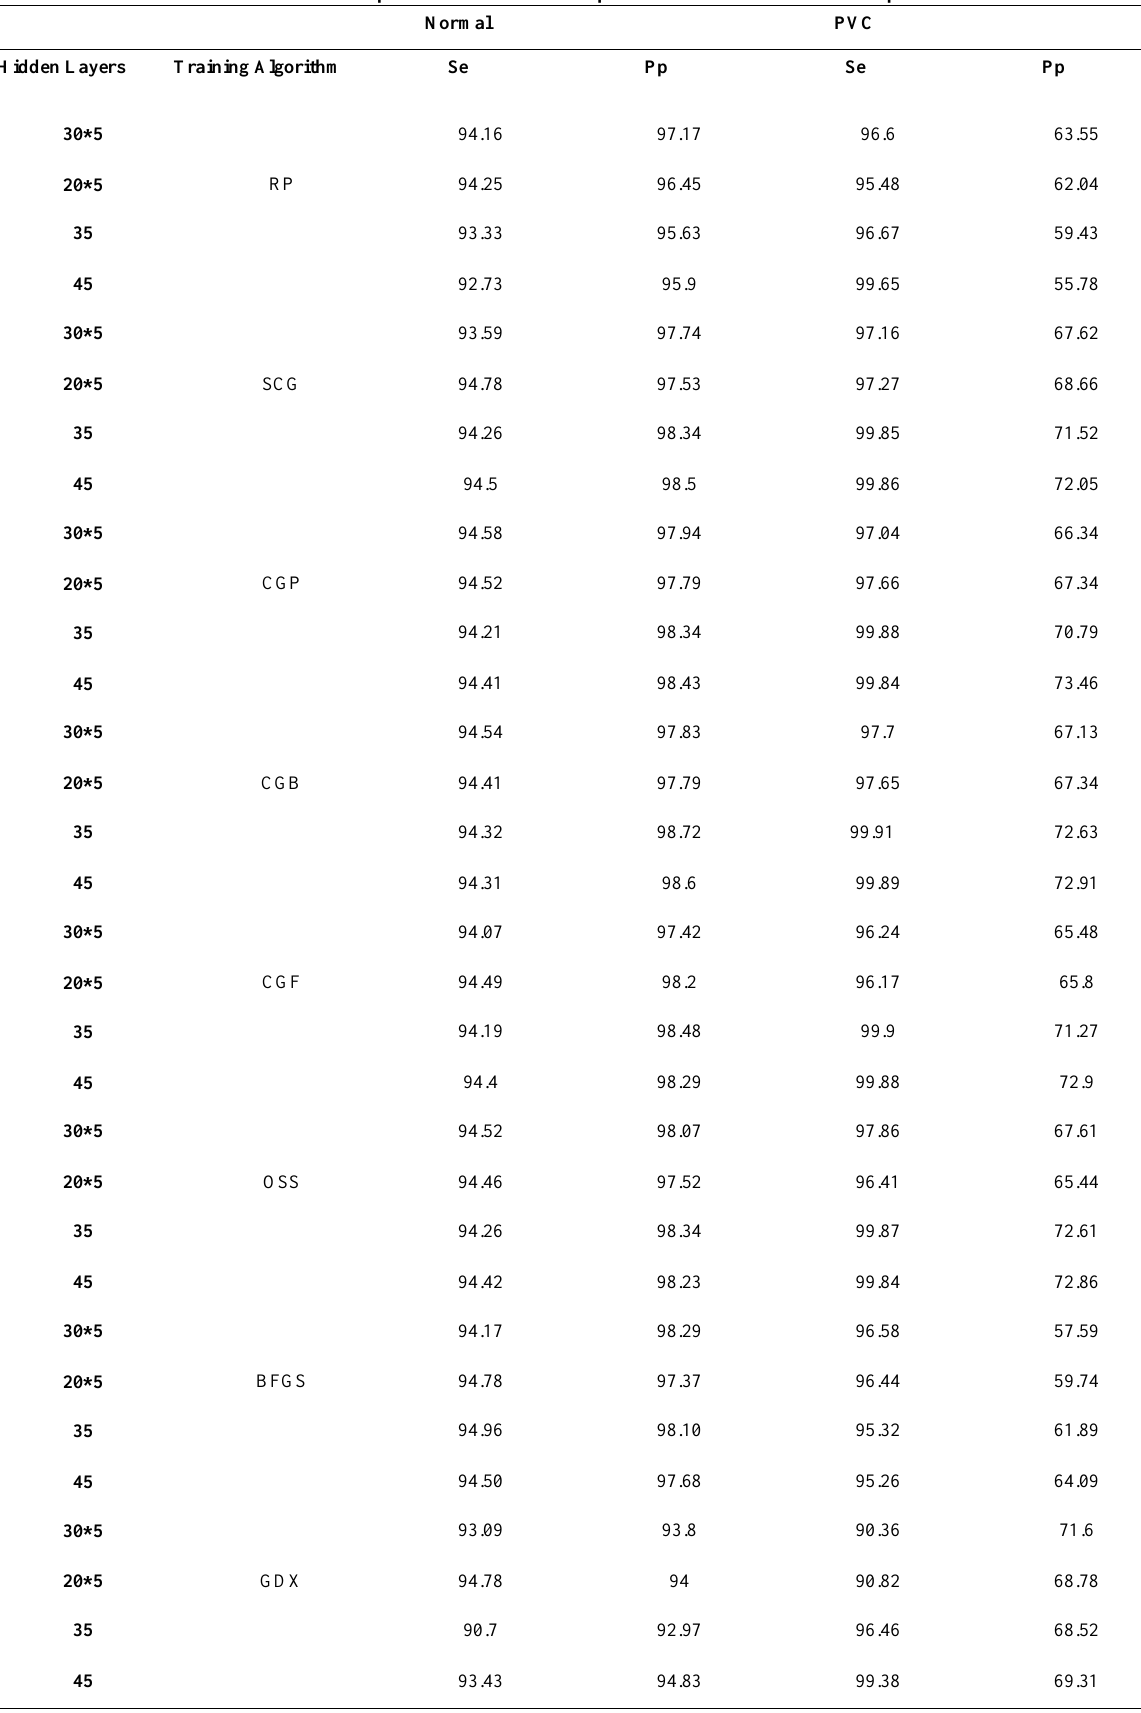
Table 5. Comparative results of two performance metrics Se and